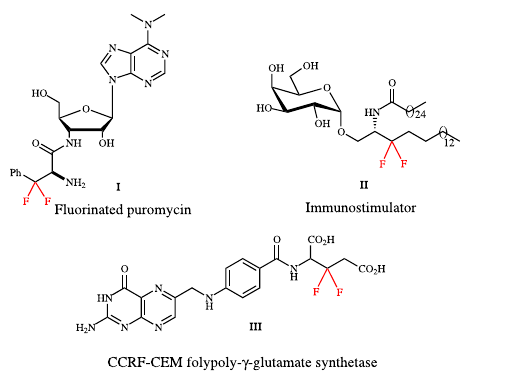
Enantiomeric excess ( ee ) determined via chiral-phase HPLC analysis. d Cat. G (5mol%) was used; 4h. e Cat. G (1mol%) was used; 24h. f Enantiomer was